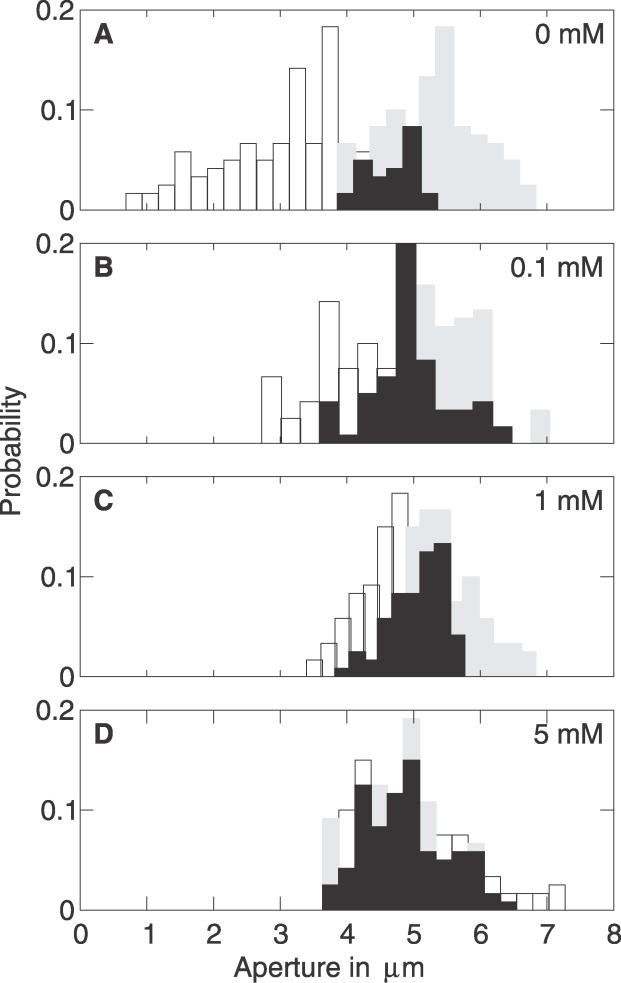
Effect of Cytosolic pH Clamp (Increasing Concentrations of Na-butyrate from 0 to 5 mM) on ABA-Induced Stomatal ClosureThe histograms show the distribution of stomatal apertures without ABA treatment (gray bars) and with 50 μM ABA (white bars). Throughout, the x-axis gives the stomatal aperture size and the y-axis indicates the fraction of stomata for which that aperture size was observed. The black columns indicate the overlap between the 0 μM ABA and the 50 μM ABA distributions. Note that the data of (A) and those of Figure 3A are identical; these data are reproduced here for ease of comparison with panels (B–D).